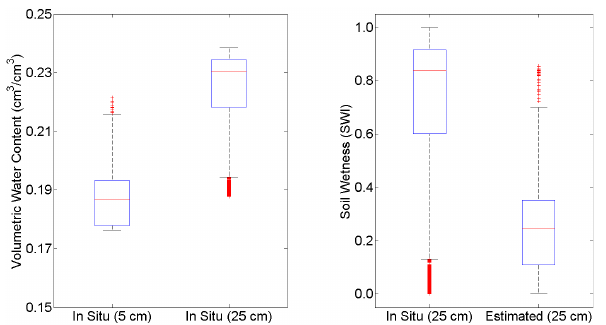
Figure 14 . Box plots of (left) volumetric water content at the 5 and 25 cm layers and (right) SWI Fig. 14. Box plots of (left) volumetric water content at the 5 and from 25 cm in situ observations and 25 cm in situ estimates. The box plots show data from all Oklahoma stations. 25cm layers and (right) SWI from 25cm in situ observations and 25cm in situ estimates. The box plots show data from all Oklahoma stations.